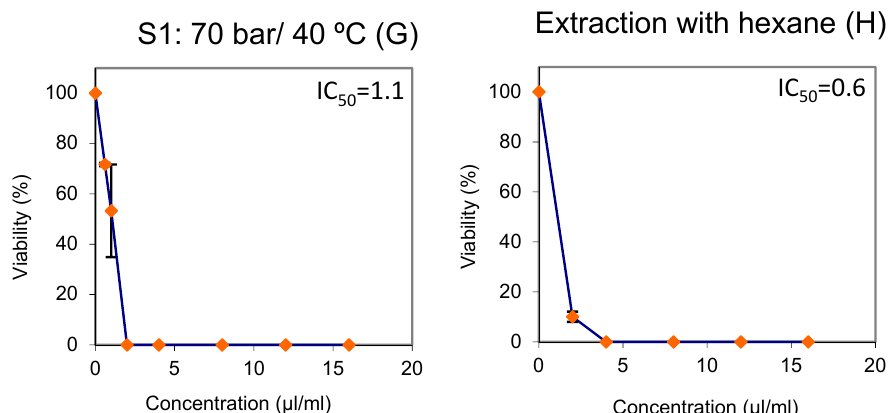
Figure 3. Viability of HL60 cells treated for 72 h either with the extracts collected into each one of the two separators; S1 ( A , C , E , G ) and S2 ( B , D , F ) or with hexane ( H ). The curves represent the percentages with respect to the results obtained from three independent experiments on the control substance (mean ± SD).